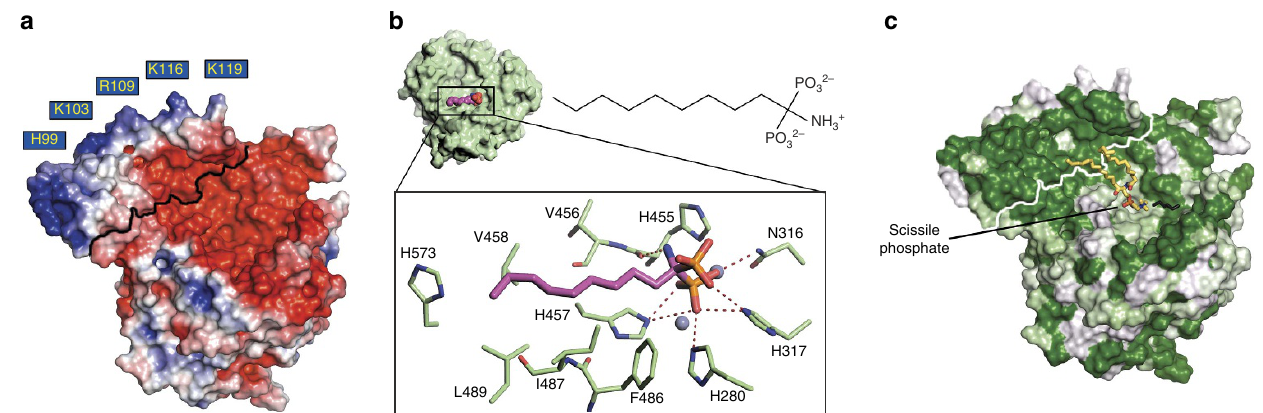
Figure 6 | Electrostatic surface and substrate-binding site of ASMase. ( a ) Electrostatic surface representation of open ASMase contoured at ± 3kT. The calculation was done at pH 7 to highlight relative charge differences, which are otherwise masked at pH 5. Positively charged residues proposed to interact with anionic membrane lipids are labelled. A black line demarcates the ASMase sap :ASMase cat boundary. A green outline marks the lipid-interacting surface on ASMase sap . ( b ) AbPA inhibitor bound to ASMase. Left: inhibitor shown as CPK spheres. Right: chemical structure of AbPA. Close-up, electrostatic interactions (red dashes) between AbPA (purple tail, orange and red phosphate) and zincs (spheres) and protein residues (green). ( c ) ASMase surface coloured by polar (white) to hydrophobic (dark green). A white line demarcates the ASMase sap :ASMase cat boundary. Sphingomyelin (yellow sticks) was docked manually into the active site. For comparison, the end of the AbPA lipid tail is shown as black sticks.